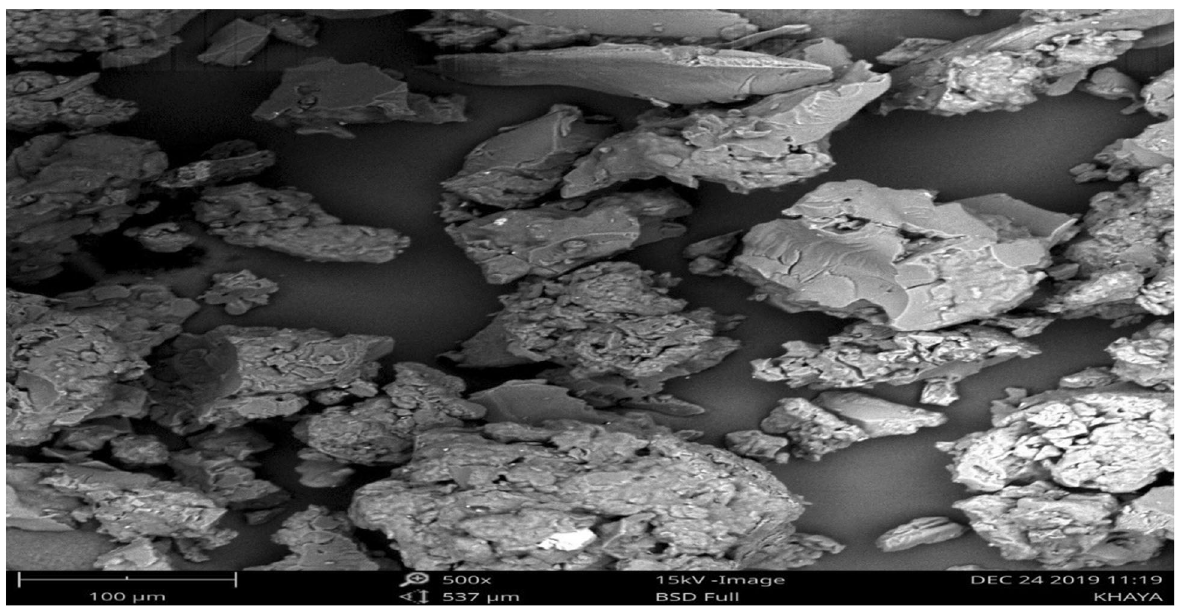
Fig. 3 SEM micrograph of Khaya senegalensis